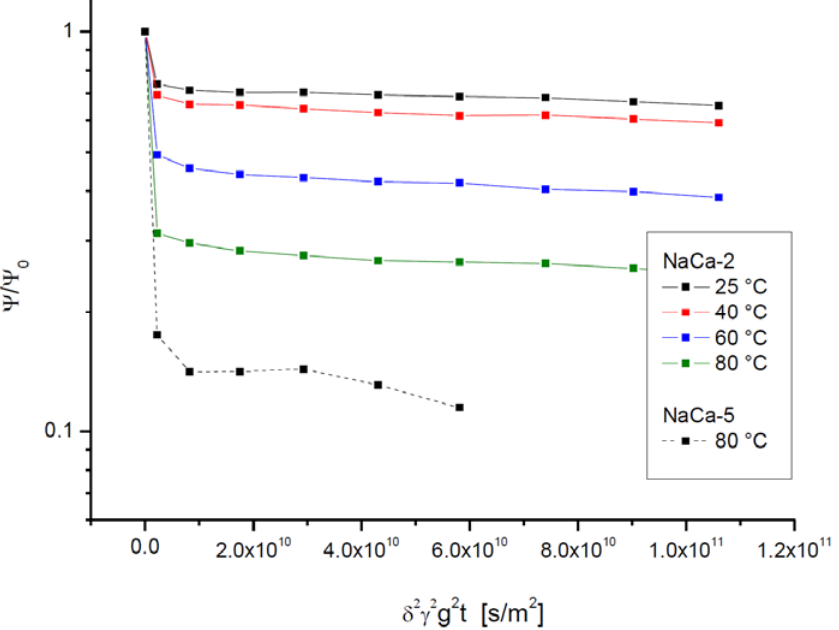
Figure 9. PFG NMR attenuation curves for propane in NaCa-LTA-2 and NaCa-LTA-5 at different temperatures for an observation time of 10